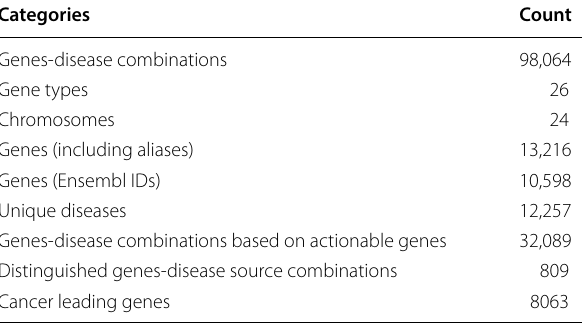
Table 2 PAS-Gen database description and